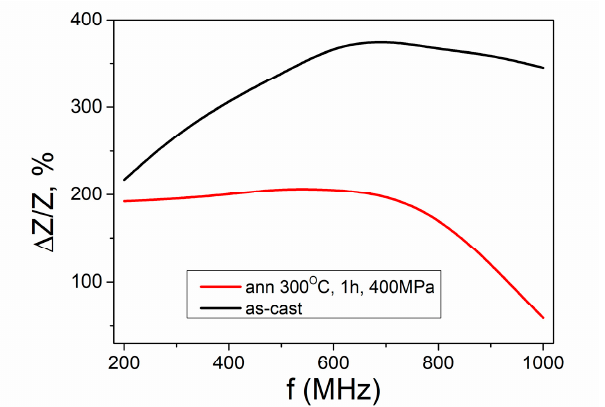
Figure 9. GMI dependences measured in the locations corresponding to room temperature and to annealing temperature of 300 °C.